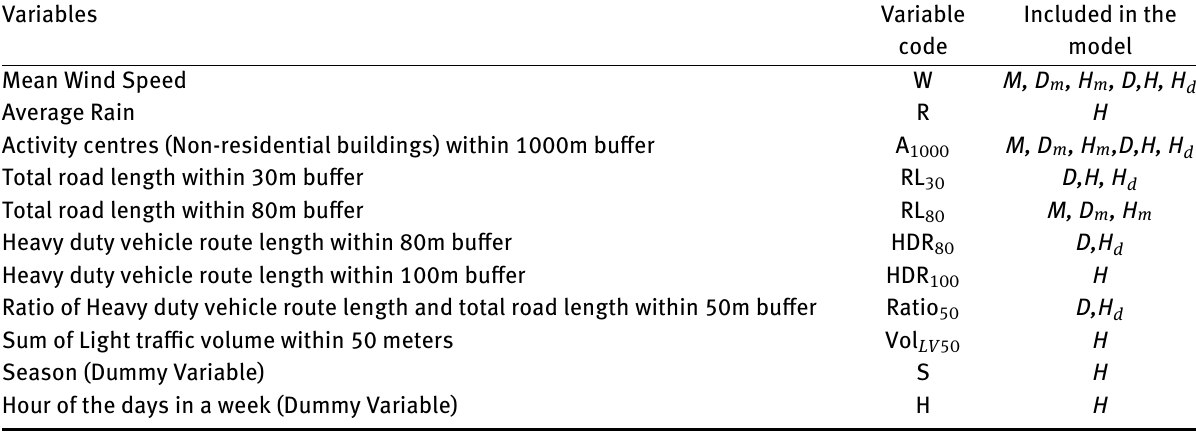
Included in the code model